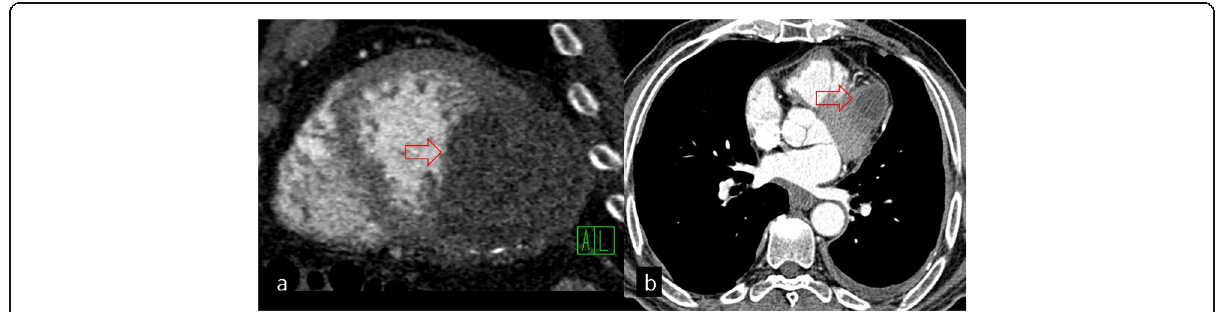
Fig. 16 Cardiac involvement of hydatid cyst. a Hydatid cyst with calcification in the left ventricle is seen on the short-axis CT image (red arrow). b Hydatid cyst in the left ventricle is demonstrated in another patient (red